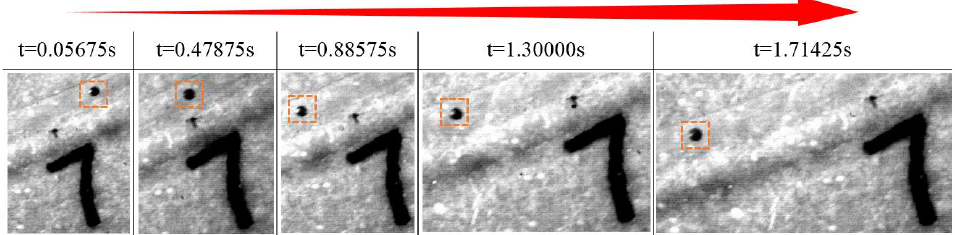
Figure 2. The motion state of the W/O droplets in microchannels captured by high-speed photog-